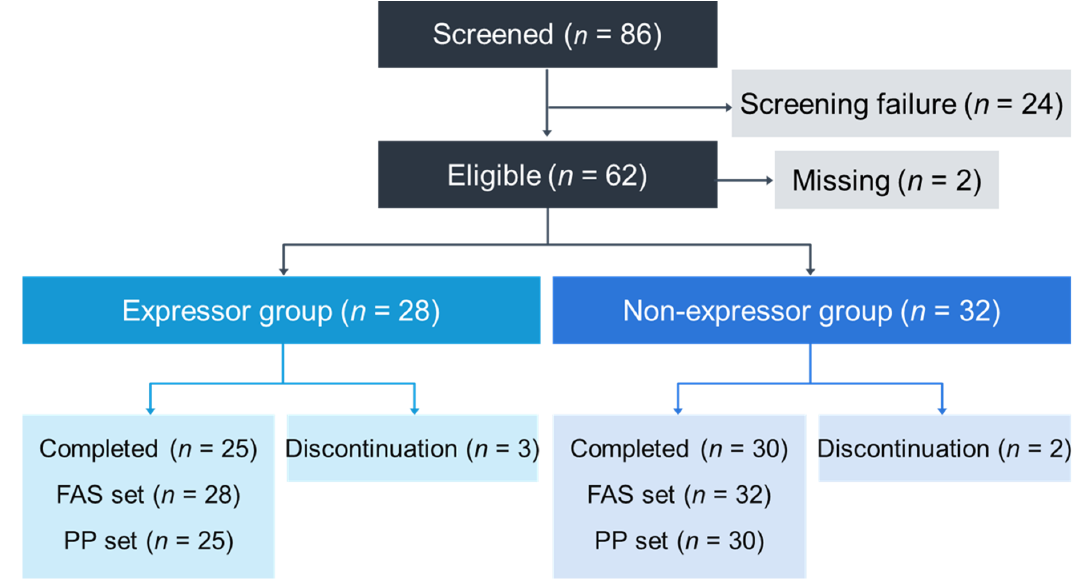
Figure 1. Study population. FAS, full analysis set; PP, per-protocol set.